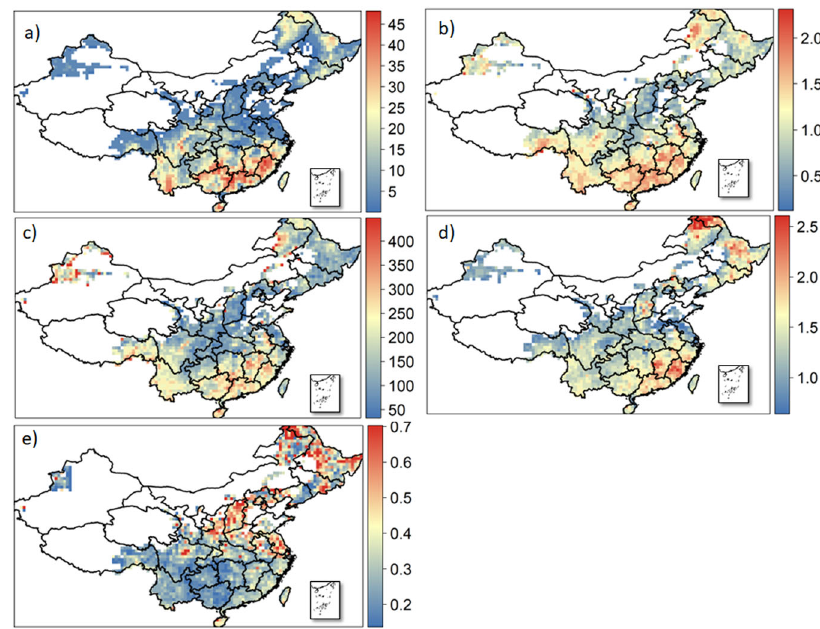
Fig. 2 Spatial patterns of disturbance regimes within each 0.5° grid cell across China ’ s forests. ( a ) total annually disturbed forest area (km 2 yr − 1 ), ( b ) normalized percent of forest disturbed annually (% yr − 1 ), ( c ) disturbance frequency (# of patches per 1000 km 2 forest), ( d ) mean patch size (ha), and ( e ) fi re severity ( Δ NDVI, delta Normalized Difference Vegetation